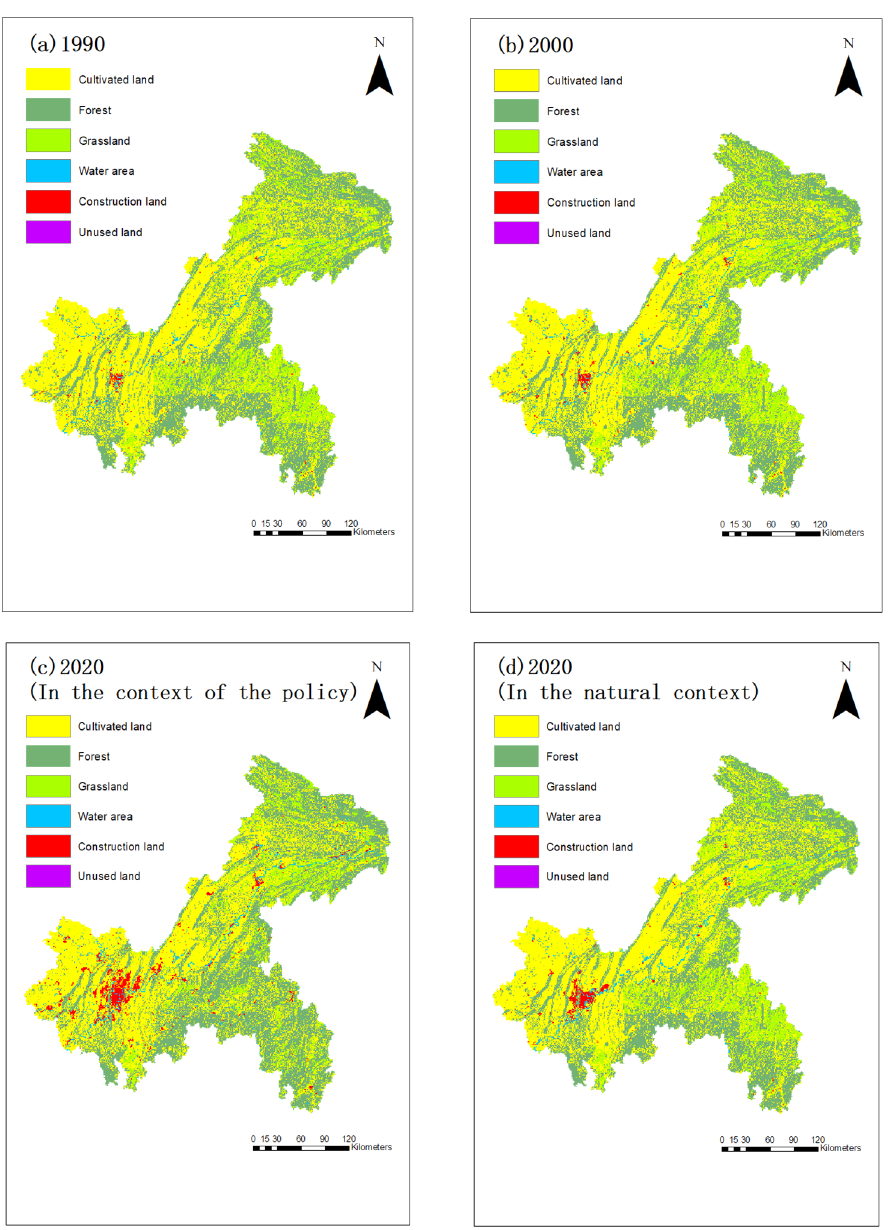
Figure 8. Spatial distribution of LUCC: ( a ) 1990, ( b ) 2000, ( c ), 2020 (in the policy context), and ( d ) 2020 (in the natural context).